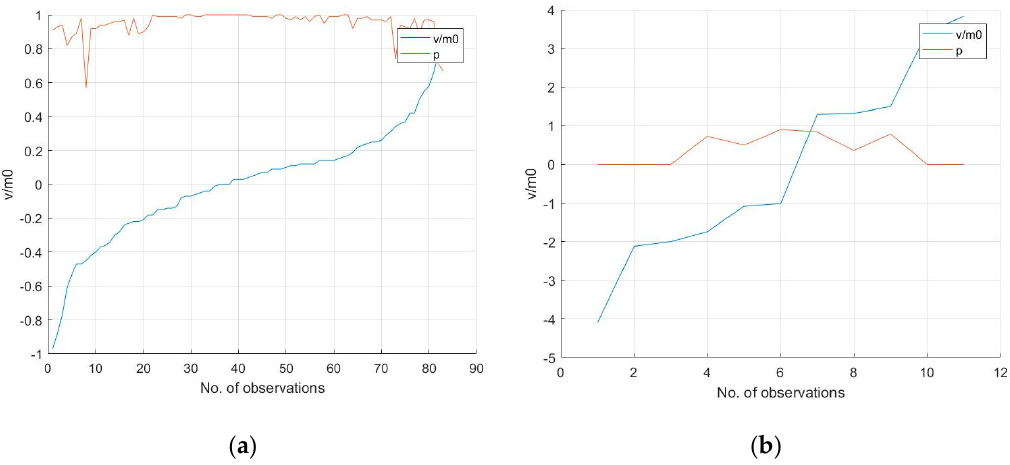
Figure 11. ( a ) Relationships between v/m0 and weight P, with v less than m0. ( b ) Relationships between v/m0 and weight P, with v greater than m0.